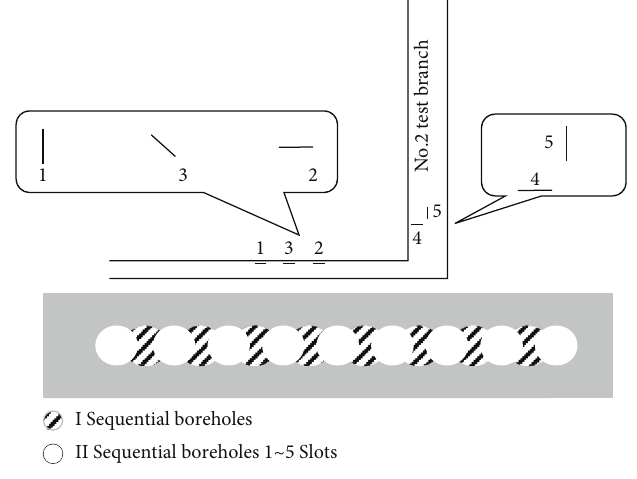
Figure 10: Layout of slots.